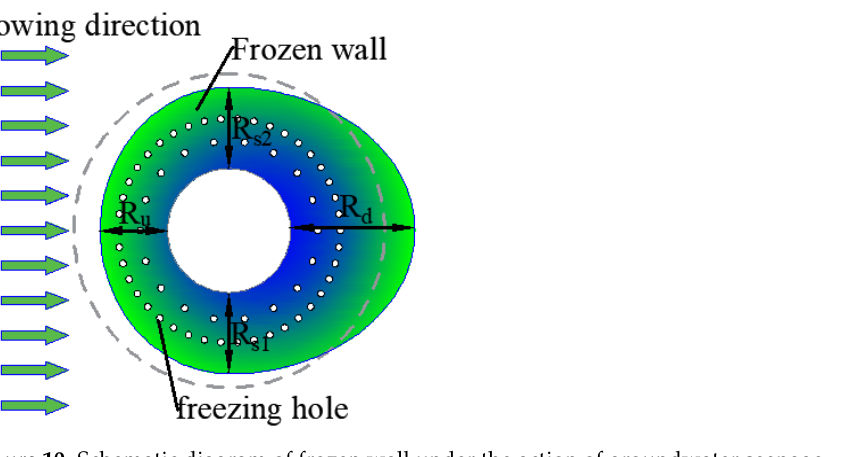
Figure 10. Schematic diagram of frozen wall under the action of groundwater seepage.